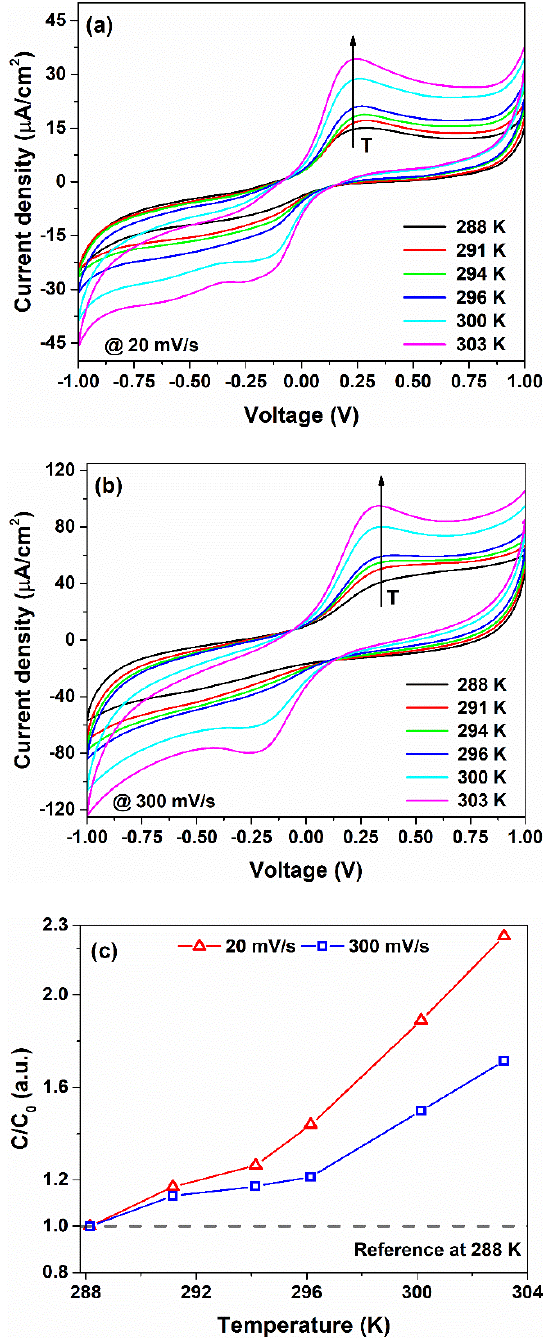
Figure 2. ( a ) Cyclic voltammetry curves measured in a temperature range between 288 and 303 K at ( a ) 20 and ( b ) 300 mV/s. ( c ) Temperature dependence of the normalized capacitance extracted by using Equation (1).